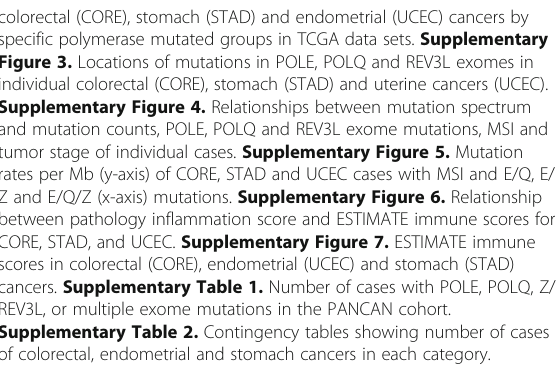
colorectal (CORE), stomach (STAD) and endometrial (UCEC) cancers by specific polymerase mutated groups in TCGA data sets. Supplementary Figure 3. Locations of mutations in POLE, POLQ and REV3L exomes in individual colorectal (CORE), stomach (STAD) and uterine cancers (UCEC). Supplementary Figure 4. Relationships between mutation spectrum and mutation counts, POLE, POLQ and REV3L exome mutations, MSI and tumor stage of individual cases. Supplementary Figure 5. Mutation rates per Mb (y-axis) of CORE, STAD and UCEC cases with MSI and E/Q, E/ Z and E/Q/Z (x-axis) mutations. Supplementary Figure 6. Relationship between pathology inflammation score and ESTIMATE immune scores for CORE, STAD, and UCEC. Supplementary Figure 7. ESTIMATE immune scores in colorectal (CORE), endometrial (UCEC) and stomach (STAD) cancers. Supplementary Table 1. Number of cases with POLE, POLQ, Z/ REV3L, or multiple exome mutations in the PANCAN cohort. Supplementary Table 2. Contingency tables showing number of cases of colorectal, endometrial and stomach cancers in each category. Abbreviations POLE: Polymerase epsilon; POLQ: Polymerase theta; POLZ/REV3L: REV3 like, DNA directed polymerase zeta (POLZ) catalytic subunit; TCGA: The Cancer Genome Atlas; MSI: Micro Satellite Instability; MSS: Micro Satellite Stability; TMB: Tumor Mutation Burden; TNM: Tumor, lymph Node, Metastasis;